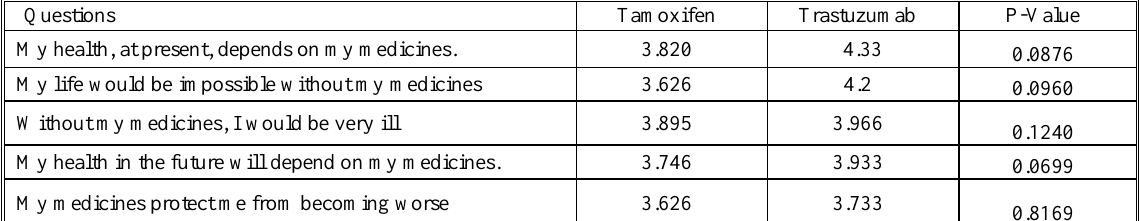
Table 2. Specific-Necessity (BMQ-SN) for both Tamoxifen and